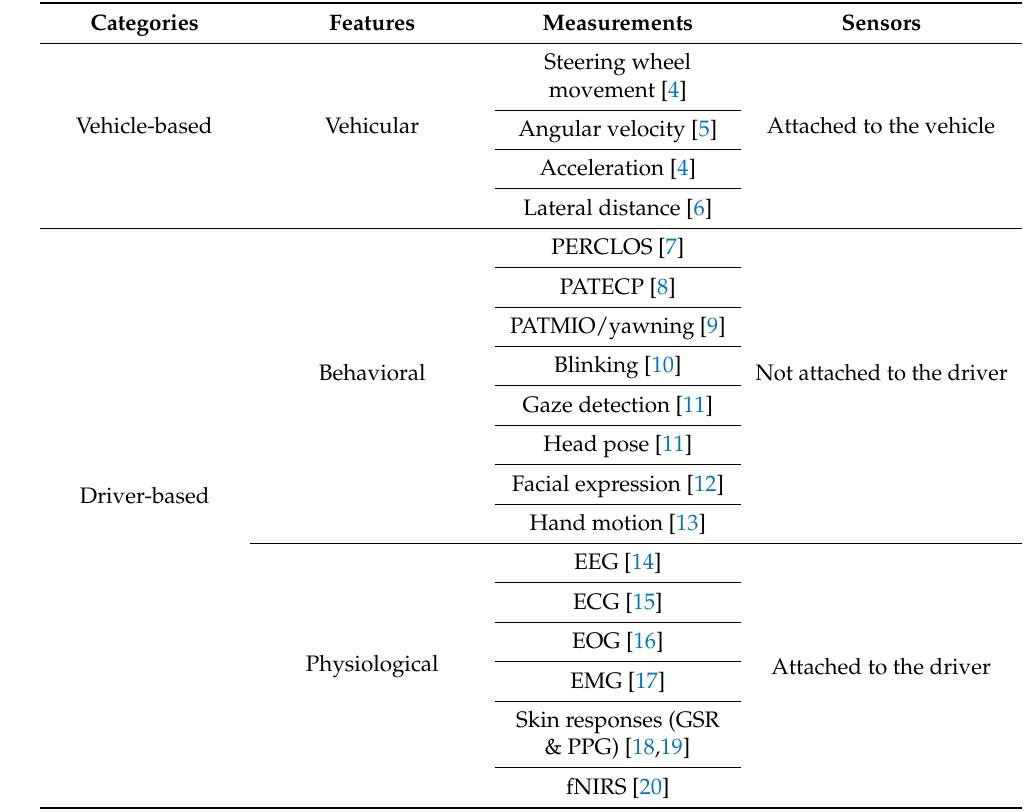
Table 1. Different methods of drowsiness